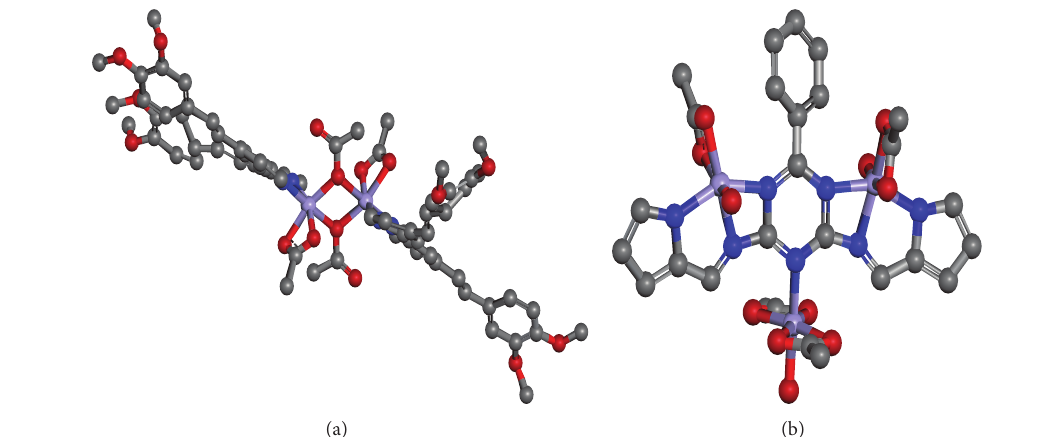
Figure 3: Molecular models for (a) trans -[Fe 2 (CH 3 COO) 4 (L3]) and (b) [Fe 3 (CH 3 COO) 4 (H 2 O) 4 (L2)] ( 2 ). H atoms are removed for